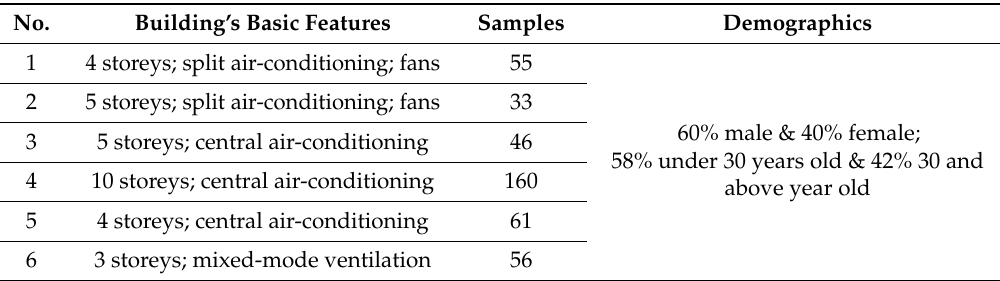
Table 1. Surveyed office buildings and